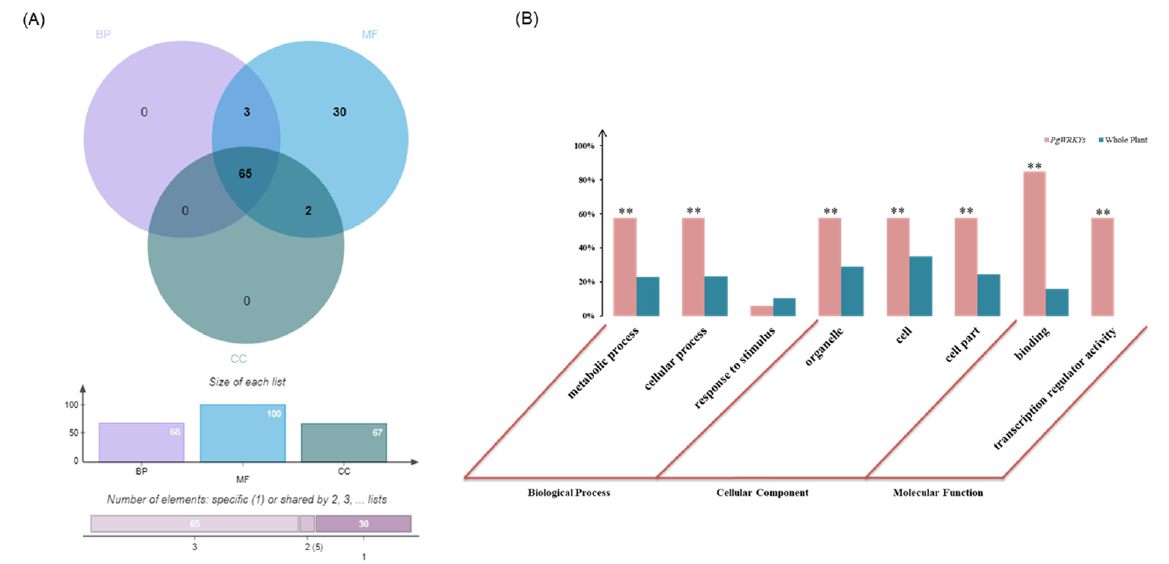
Figure 4. Functional categorization and GO term enrichment of the PgWRKY gene transcripts. ( A ) Venn diagram of the PgWRKY gene transcripts among the biological process (BP), molecular func- tion (MF) and cellular component (CC) functional categories. ( B ) Subcategories (Level 2) into which the PgWRKY transcripts are categorized and GO enrichments. The GO terms of the transcripts ex- pressed in 14 tissues of the four-year-old of ginseng used for identification of the PgWRKY genes as the background control for the enrichment analysis. “**” as significant at p ≤ 0.01; “No asterisk” as